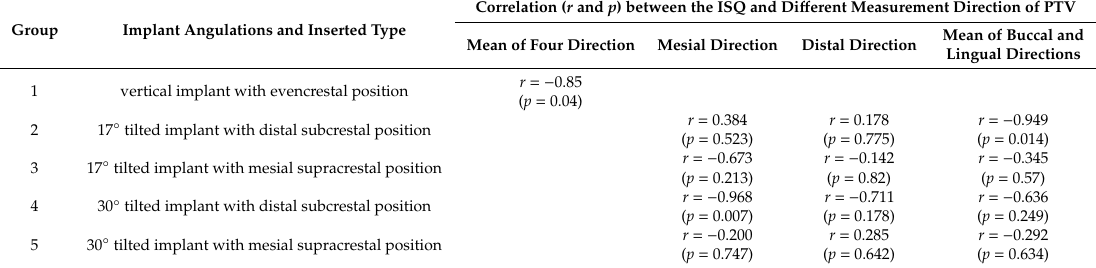
Table 3. Correlations between the ISQ and the PTV along various measurement directions in the five groups.